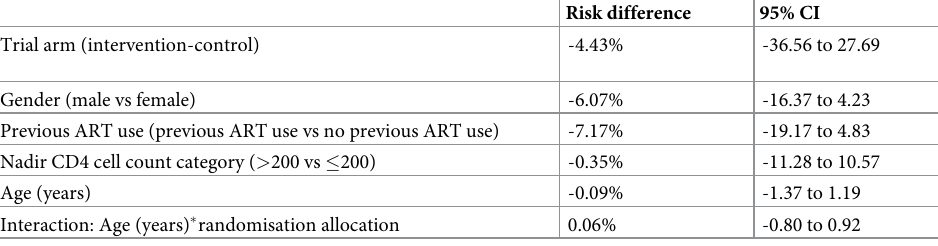
Table 5. Results of additive binomial model examining the association between trial arm and primary outcome (VL < 400 copies/mL) including an interaction term between the intervention and